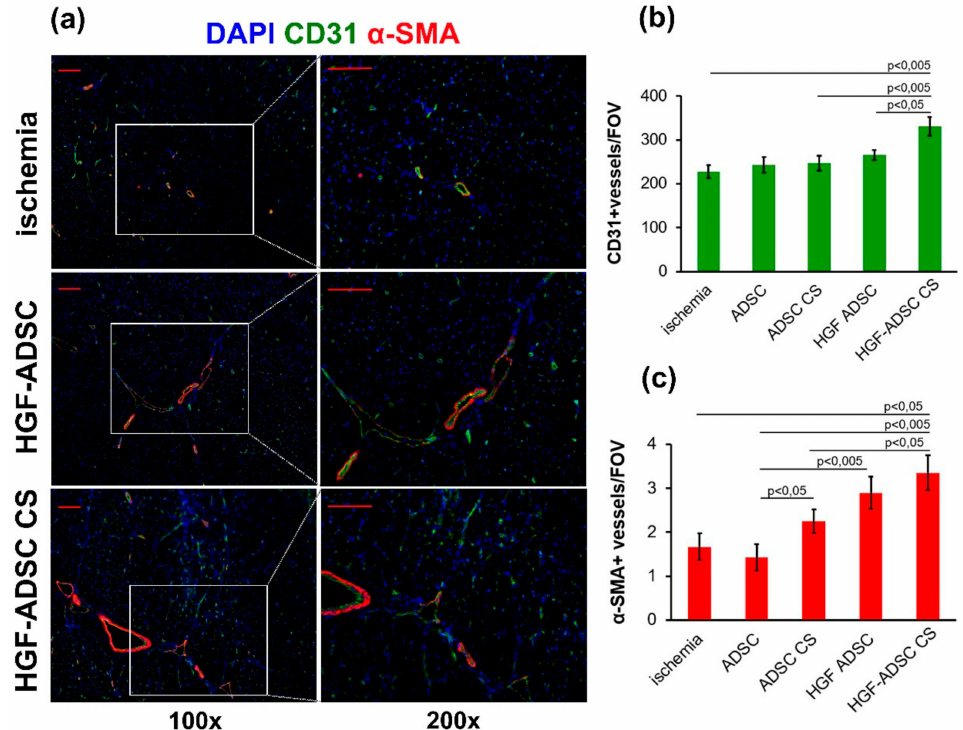
Figure 4. Blood vessel density in ischemic muscle at day 14 after ischemia induction and cell sheets / cells transplantation. ( a ) Representative images of m. tibialis anterior sections from ischemia, HGF-ADSC and HGF-ADSC CS groups stained against murine CD31, α -SMA and DAPI (100 × and 200 × magnification); ( b , c ) graphical presentation of blood vessel density analysis with average group values per FOV. Data are presented as mean ± SEM (Mann–Whitney U-test). Scale bar = 50 µ m. HGF = hepatocyte growth factor, CS = cell sheet, ADSC = adipose-derived stromal cells. α -SMA = α -smooth muscle actin, DAPI = 4 (cid:48) ,6-diamidino-2-phenylindole, FOV = field of